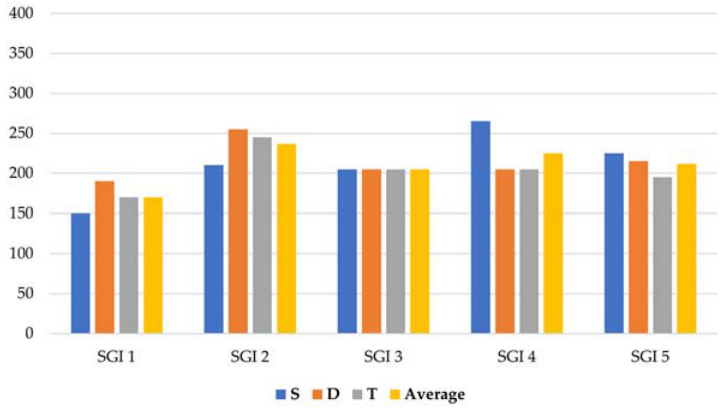
Figure 6. Overall SGI assessment according to the type of value—scientific, didactic, and tourist.